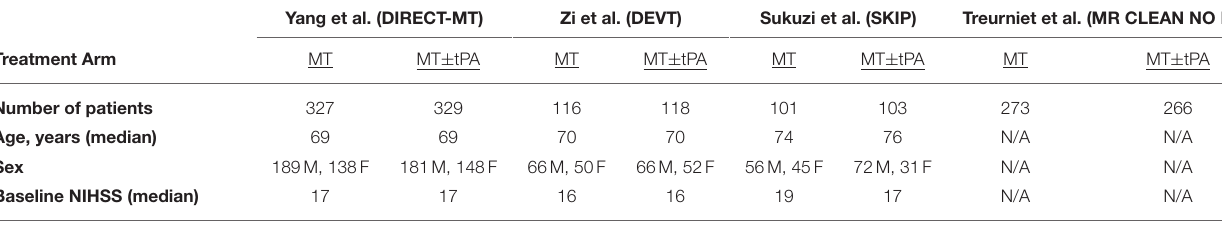
TABLE 1 | Patient characteristics of the four studies included in the meta-analysis. Yang et al. (DIRECT-MT) Zi et al. (DEVT)